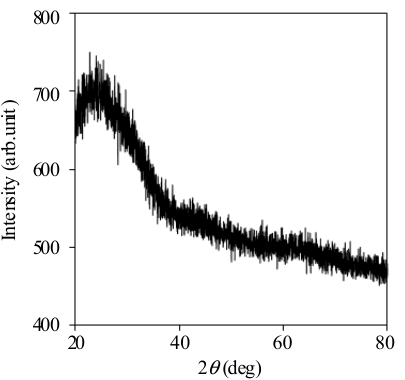
Fig. 3 XRD pattern of the nanostructured SiO 2 film prepared in this work.